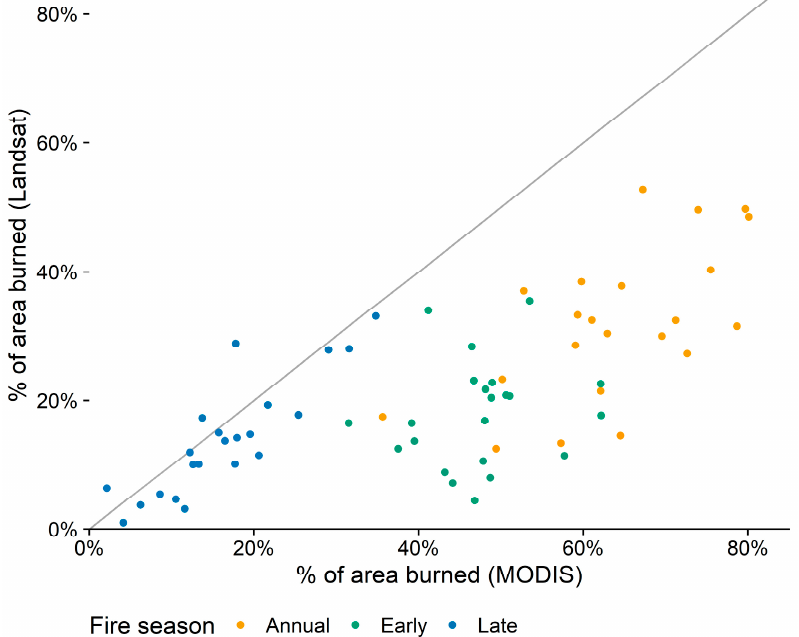
Figure 3. Scatter plot of the total annual % area of lowland Eucalyptus savannas of Kakadu National Park classified as burnt according to Landsat and MODIS fire mapping, coloured by annual (yellow), early (green) and late (blue) season totals. Diagonal line represents a 1:1 relationship. The total area of analyzed lowland Eucalyptus savannas in KNP is 11,278 km 2 .